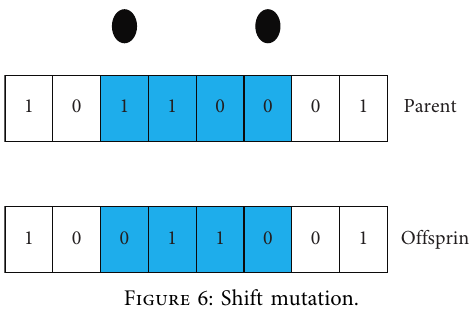
Figure 6: Shift mutation.